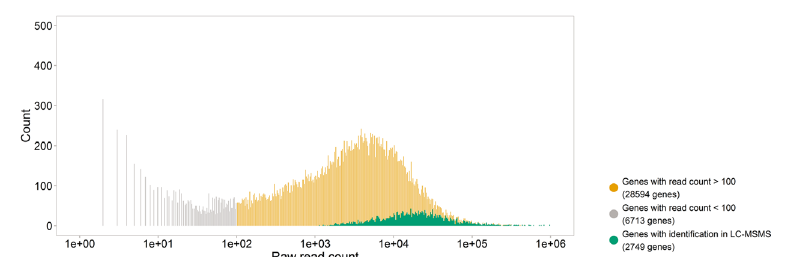
Figure 2. Identification of LC-MSMS spectra is correlated with the mRNA read count. Histogram with total read count in 18 samples visualized. Yellow: all genes in quantitative mRNA, green: all genes with identification in LC-MSMS, grey: genes with read counts below 100.